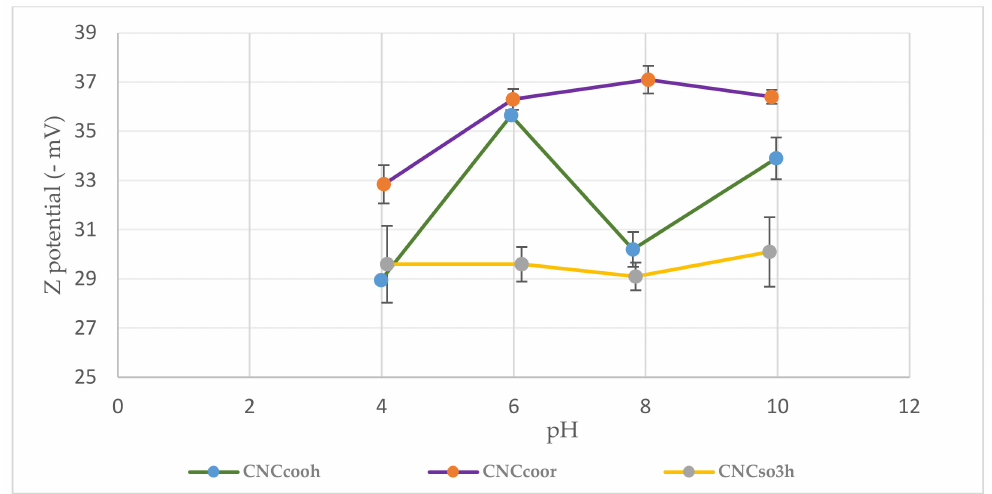
Figure 2. Z potential values versus pH of CNCs with carboxylic (CNC COOH ), sulfate half ester (CNC SO3H ) and ester groups (CNC COOR